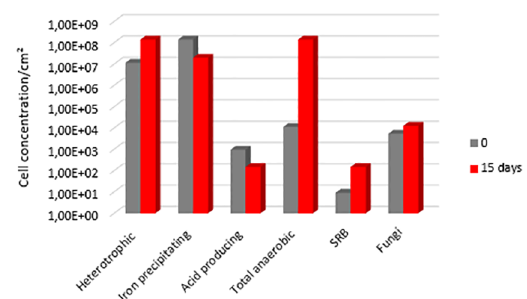
Figure 2. Microbial population of clayey soil at the beginning and the end of 15